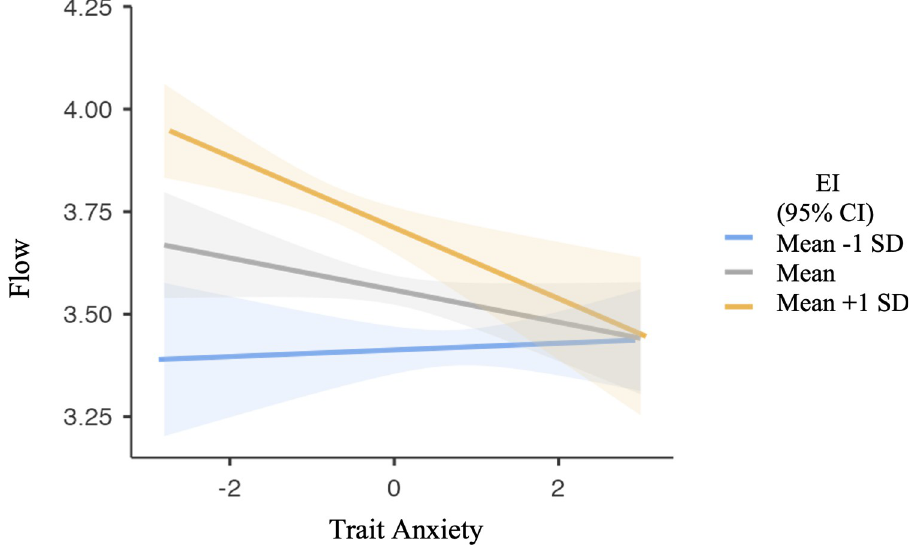
Fig 1. Simple slopes plot showing a significant interaction of EI on the Flow-Trait Anxiety relationship. There is no relationship between Trait Anxiety and Flow in those with low EI, but a significant negative relationship is observed in those with high